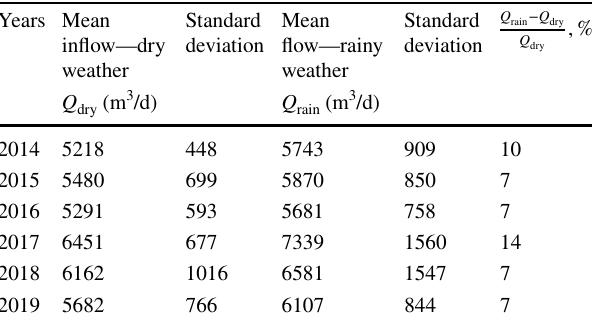
Table 4 Variability of sewage supply to WWTP in dry and rainy peri-